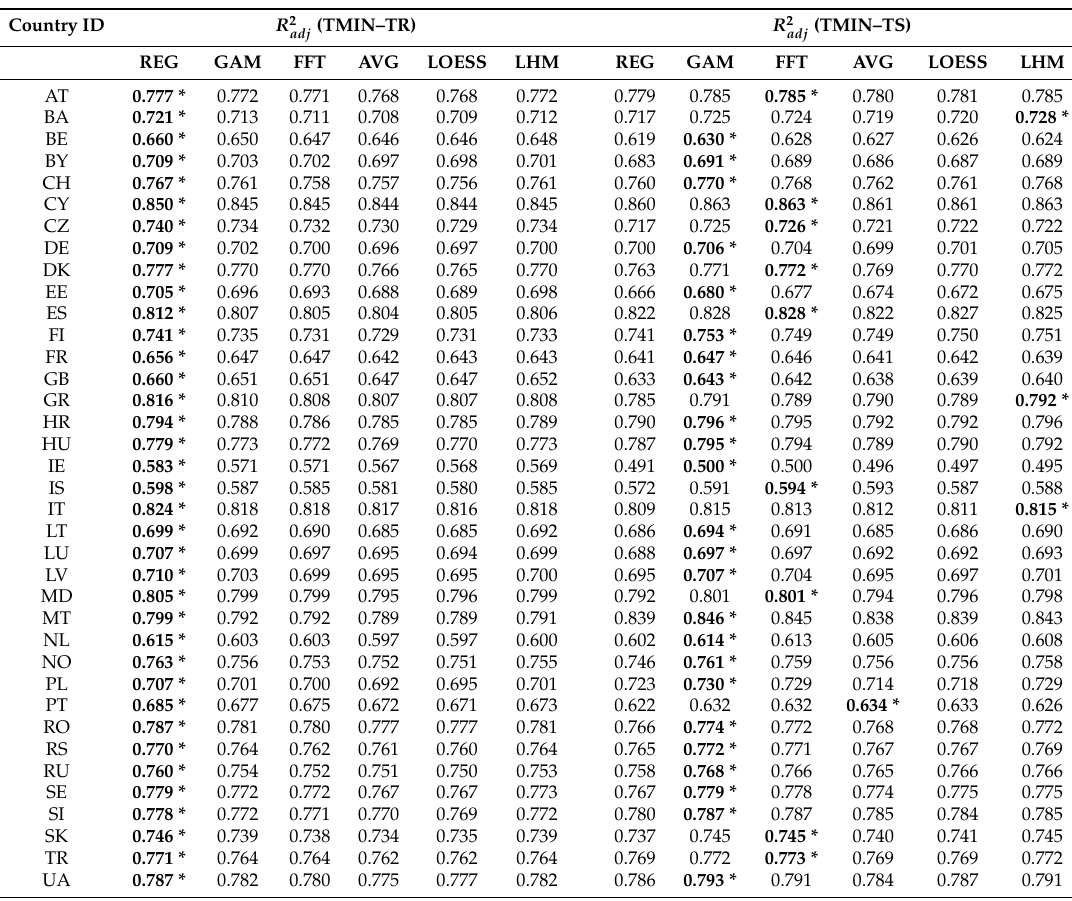
Table 3. Summary of the in-sample (TR) and out-of-sample (TS) Adjusted R-squared ( R 2 minimum temperatures, obtained with all the different methods and for all the countries. The bold values with * indicate the best method for each country and